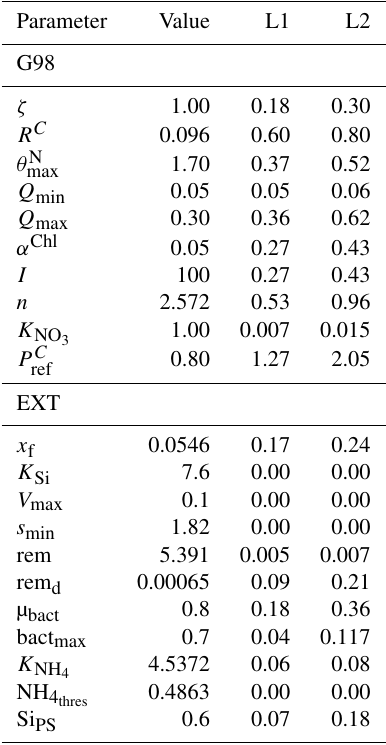
Table A4. Output of the sensitivity analysis (sensFun of the FME package in R , EXT fit on BACT + ) with the value for each parameter and different sensitivity indices obtained after quantifying the effects of small perturbations of the parameters on the output variables (POC, PON, Chl, DIN). The L1 and L2 norms are normalized sensitivity indices defined as L 1 = (cid:80) sensitivity of parameter i for model output j .